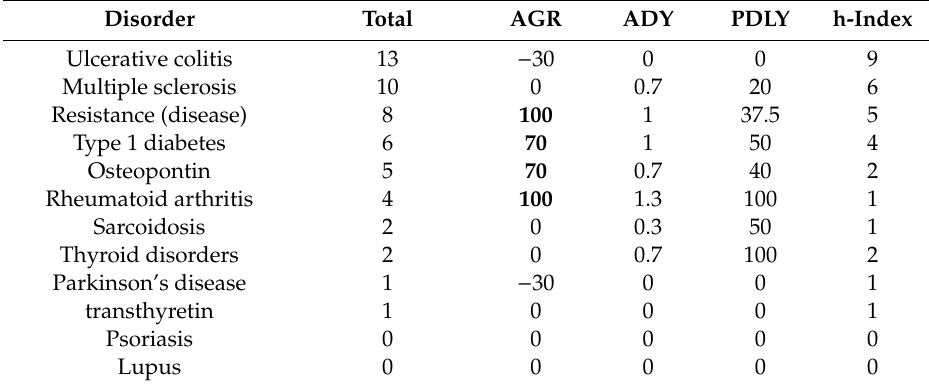
Table 7. Growth of MAP research related to autoimmune